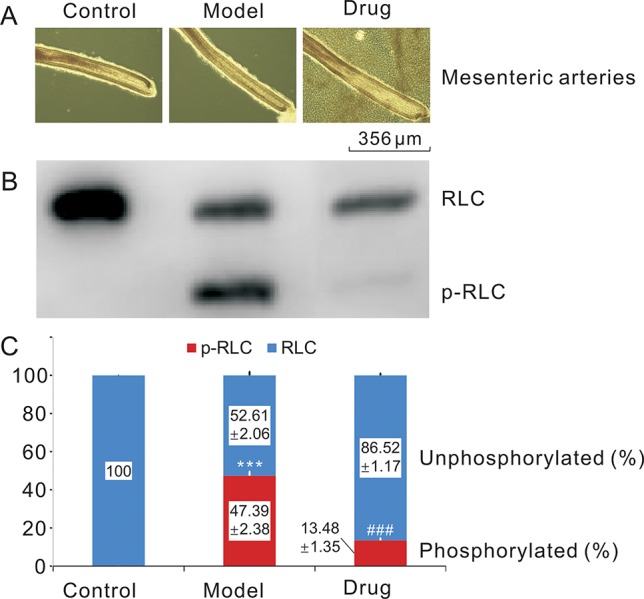
Relaxing smooth muscle and reducing RLC phosphorylation effects of neoliensinine on microvascular constriction. (A) Mesenteric arteries of three groups, (B) RLC phosphorylation by Western blot, (C) histogram of RLC phosphorylation. ***P < 0.001 and ###P < 0.001.